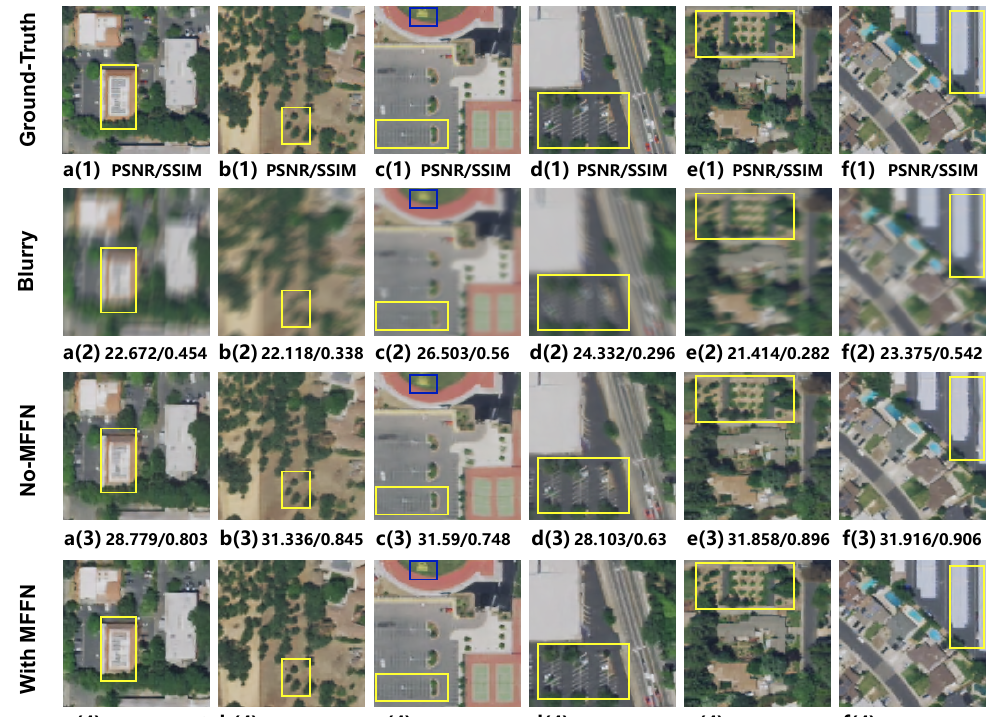
Figure 15. Visual comparison of images restored by our method with MFFN and without MFFN. Multi-level features extractor . Table 5 shows the quantitative evaluation results. Restored images acquired by Ref-MFFDN with 0-ResBlock MFE get the lowest scores on both the average PSNR metric and average SSIM metric, which demonstrates that adding the ResBlocks layer to MFE can effectively improve the quality of restored images. In other words, our network can better reconstruct latent sharp images guided by the high-level features of the reference images. When adding one to three layers of ResBlocks to the MFE, the restored images get close scores on the average PSNR and average SSIM metrics. In detail, the network with 1-ResBlock MFE achieved the highest scores in terms of average PSNR and average SSIM metrics, while the network with 2-ResBlocks MFE and the network with 3-ResBlocks MFE achieved the second-highest scores on average PSNR metric and average SSIM metric, respectively. For inference speed, each additional layer of ResBlock will increase the inference time by about 6 s on the CPU and about 0.6 s on the